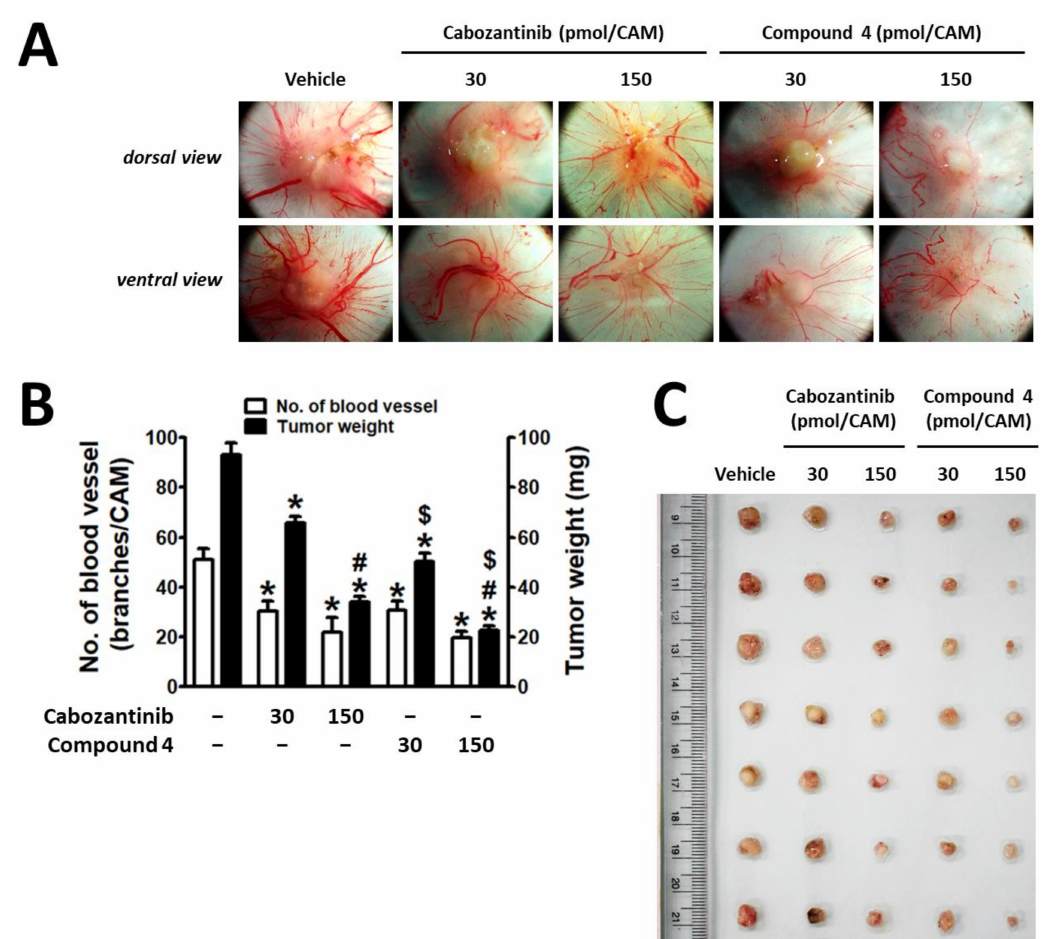
Figure 6. The anti-tumor effect of compound 4 was better than that of cabozantinib. Hep3B cells (1.5 × 10 6 cells/CAM) were inoculated on the CAM, and 2 doses of cabozantinib and compound 4 were administered during implantation ( n = 7). After 4 days of incubation, the tumor growth and tumor-induced angiogenesis on the CAM tissues shown in ( A ) were quantitated and expressed as the number of new vessel branches and tumor weight ( B ). * p < 0.05, compared to vehicle-treated group. # p < 0.05, compared to 30 pmol-treated group. $ p < 0.05, compared to cabozantinib-treated group. Tumor masses isolated from CAMs are shown in ( C